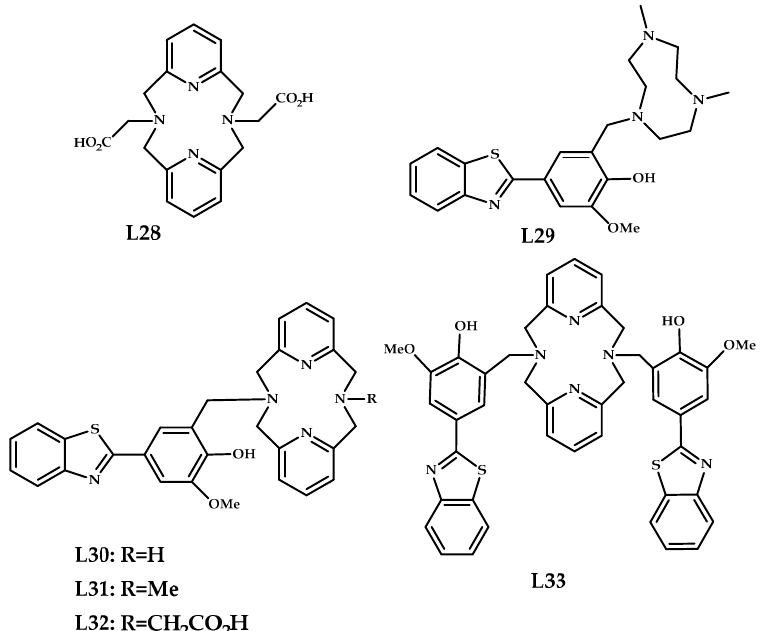
Figure 9. Benzothiazole moieties, conjugated with metal-chelating 1,4,7-triazacyclononane and 2,11-diaza[3.3]-(2,6)pyridinophane L29 – L33 , designed for A β fibrils binding, and model ligand L28 without benzotiazole moiety.